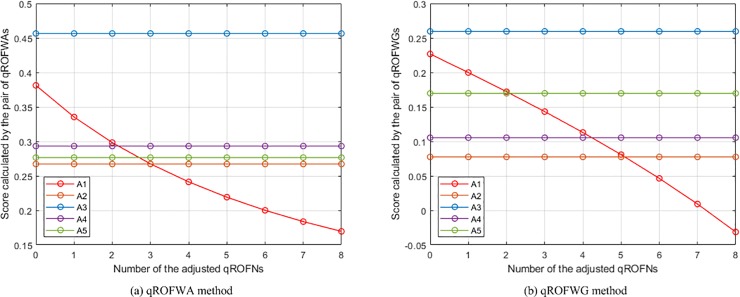
The changes of the places of A1 in the rankings of the WA and WG methods.